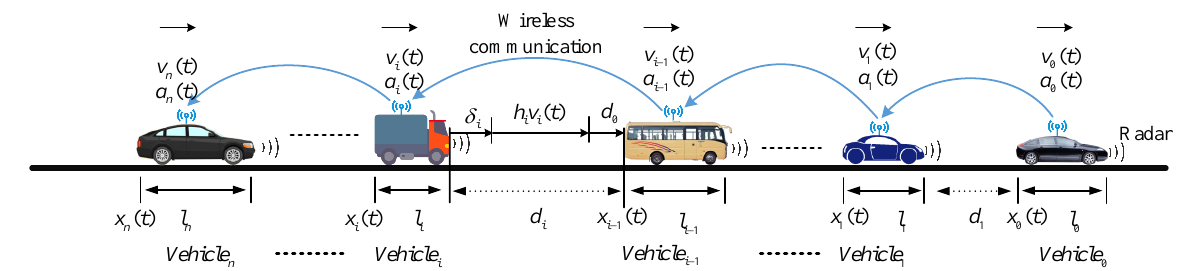
Figure 3. Schematic of a heterogeneous CACC vehicle platoon.